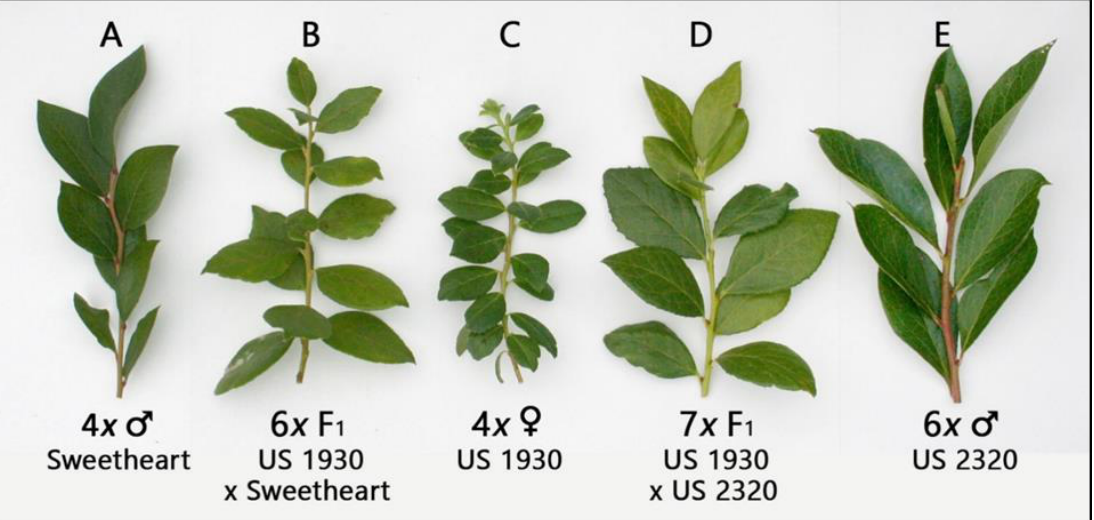
Figure 1. Leaves of 4 x US 1930, cultivar parents, and their hybrids (L to R): ( A ) 4 x V. corymbosum ‘Sweetheart, ( B ) 6 x US 2540 (=4 x US 1930 × 4 x ‘Sweetheart’), ( C ) 4 x US 1930, ( D ) 7 x US 2521-A (=4 x